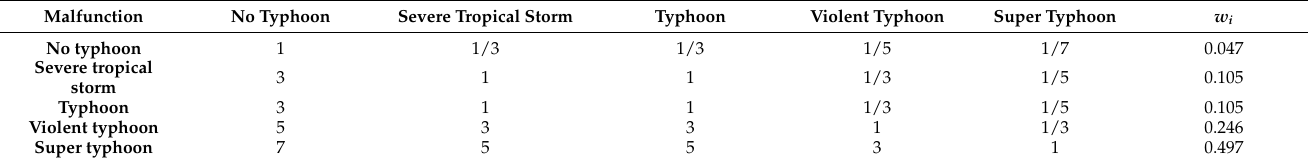
Table 5. Important degree judgment matrix of malfunction under different typhoon